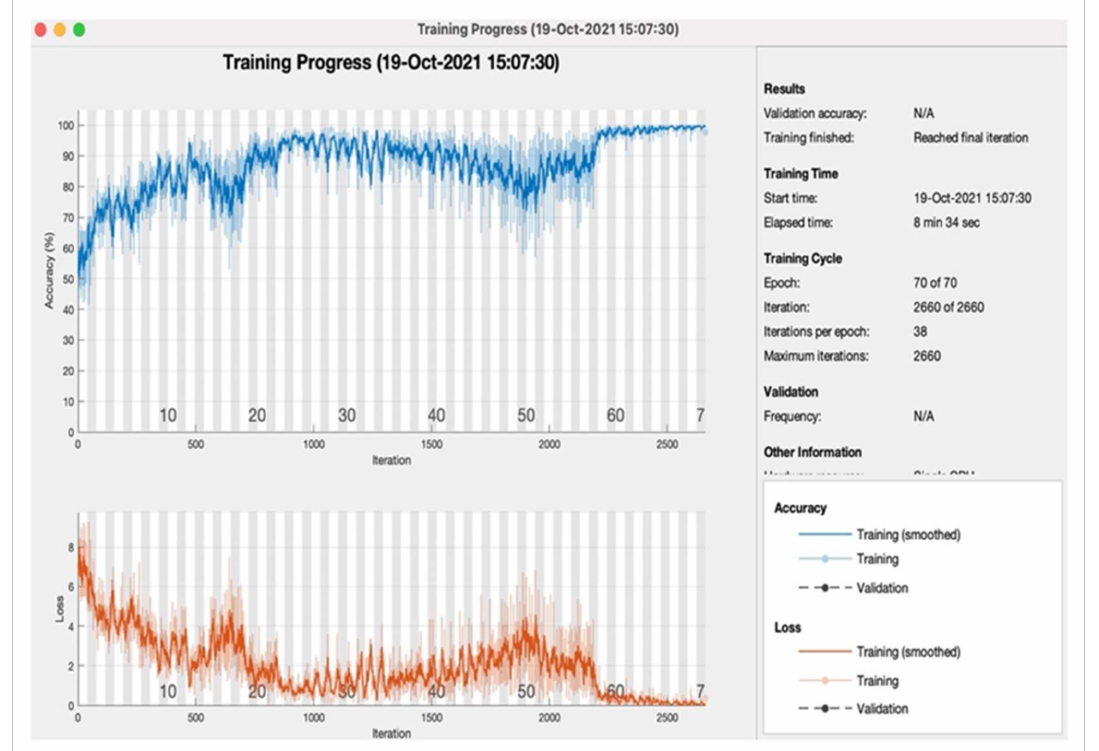
Figure 6. Proposed model of oral cancer prediction accuracy and loss with respect to iteration during training.